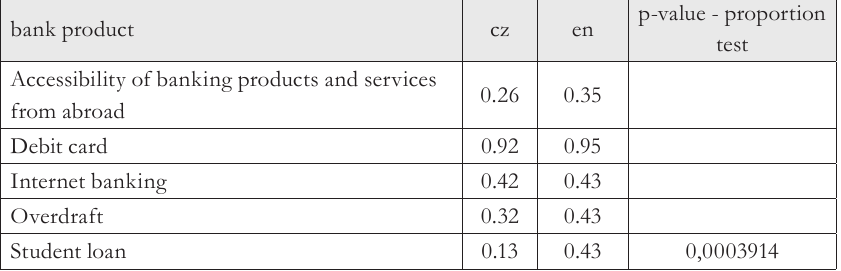
Tab. 2 – Satisfaction with bank services and products in the two investigated countries. Source: Author´s own.